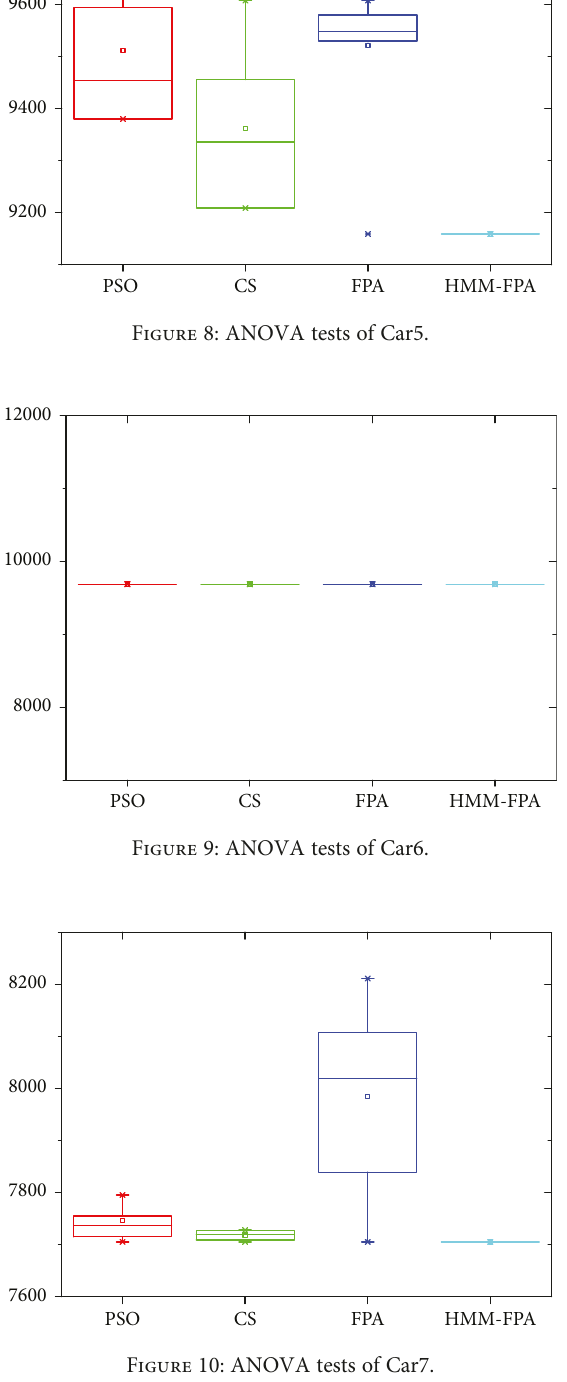
Figure 10: ANOVA tests of Car7.